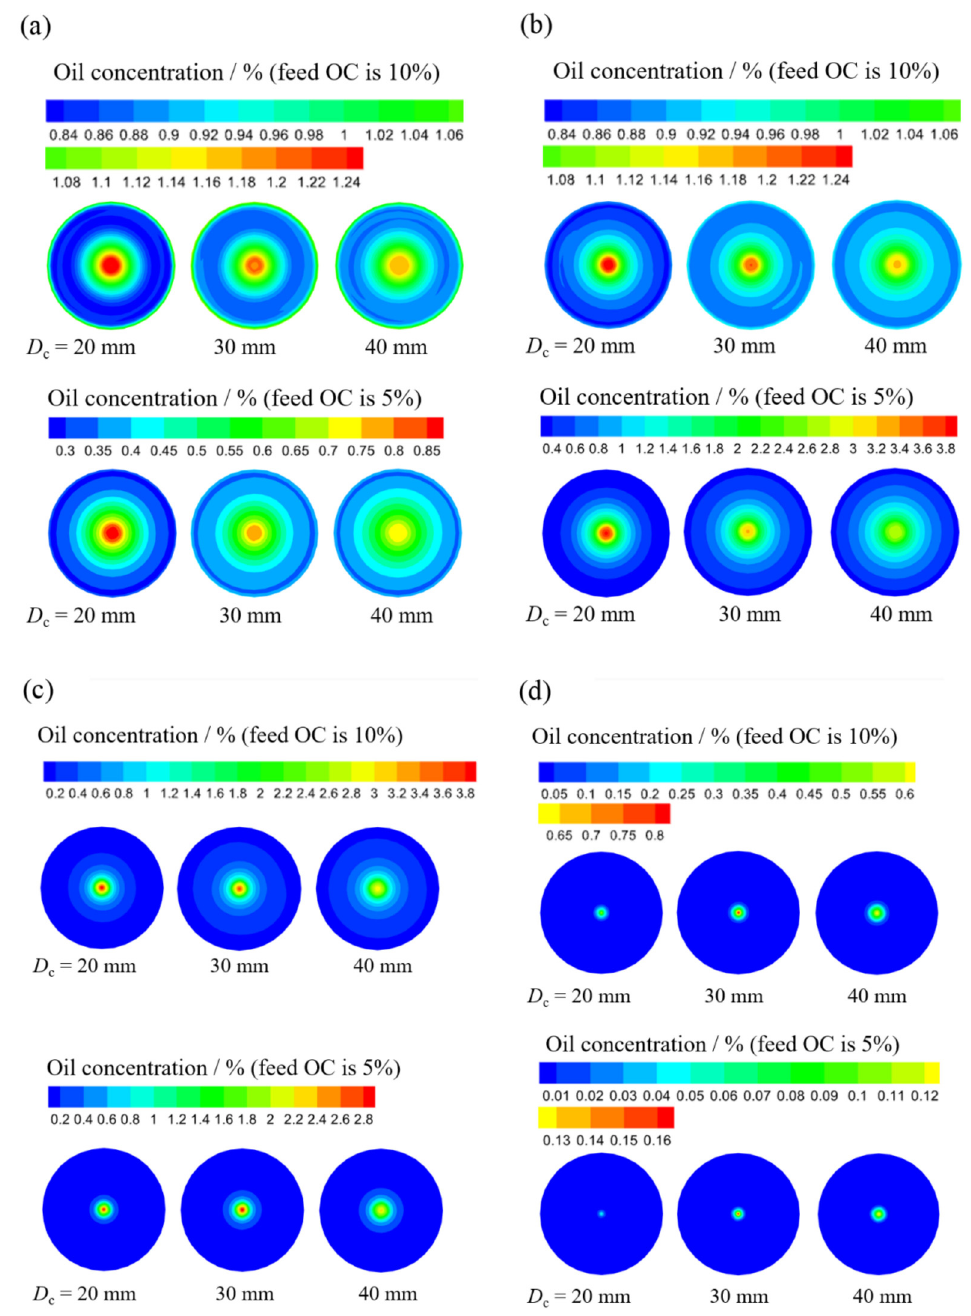
Figure 7. Comparison of OC distribution at underflow of hydrocyclone with different D c ; ( a ) oil droplet size d o = 60 µ m; ( b ) d o = 100 µ m; ( c ) d o = 200 µ m; ( d ) d o = 400 µ